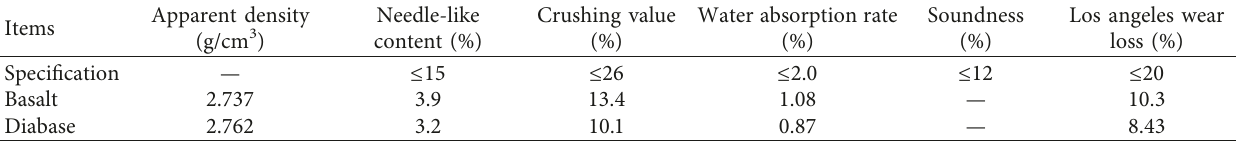
Table 1: Technical indexes of basalt coarse aggregates.